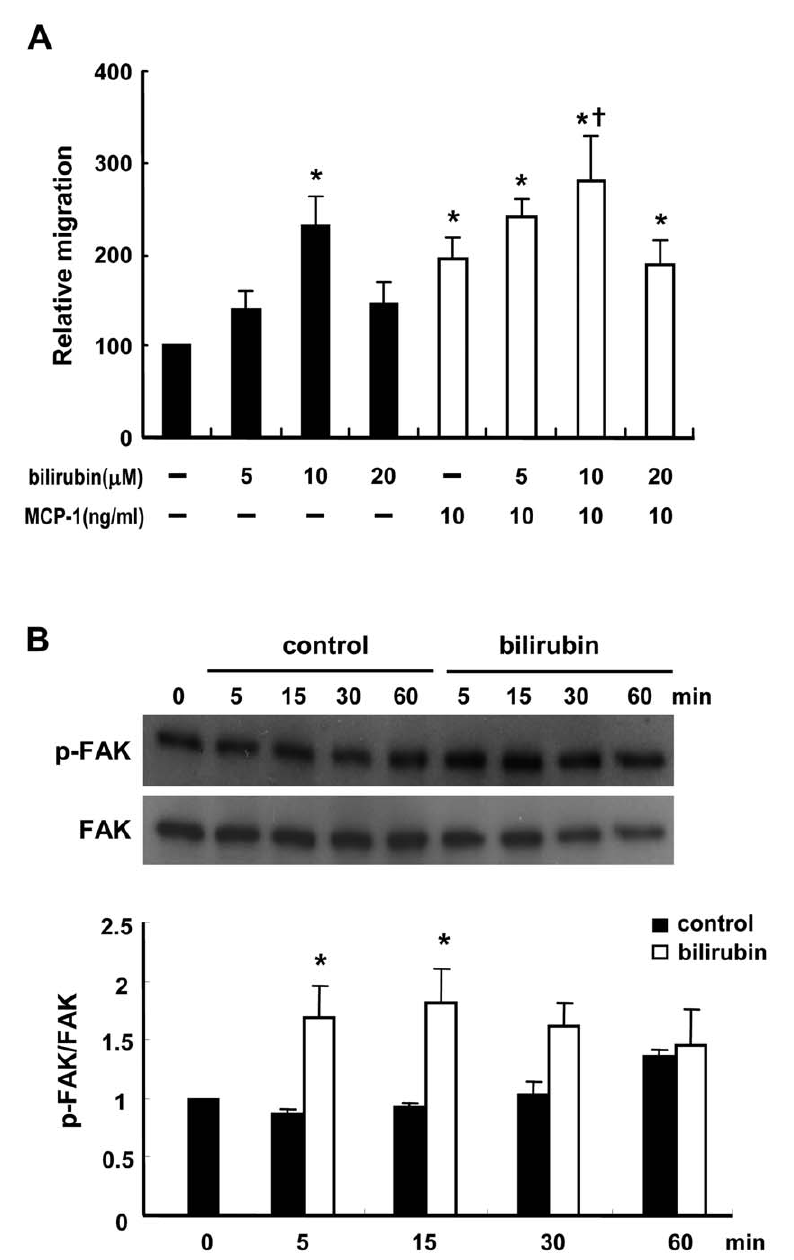
Figure 9. Bilirubin promotes macrophage migration by enhancing FAK phosphorylation. A, WT peritoneal macrophages were tested in a transwell migration assay without or with MCP-1 (10 ng/ml) and the macrophages in the upper chamber were concurrently treated without or with bilirubin at the indicated concentration. The data are the mean 6 SEM for four independent experiments. * P , 0.05 vs the untreated control. { P , 0.05 vs MCP-1 treatment. B, WT macrophages were treated without or with 10 m M bilirubin for the indicated time, then phosphorylation of FAK was examined by Western blot analysis. C, The levels of phsopho-FAK were quantified by densitometry. The data were presented as the normalized intensity relative to that of the zero-time point control group, which was set to 1. The results shown are the mean 6 SEM for three independent experiments. * P , 0.05 vs the untreated control. doi:10.1371/journal.pone.0038626.g009 levels of CD11c (M1) and mannose receptor (M2) were similar in polarization in the obese adipose tissue. Experiments were then the SVF fractions of HFD-fed WT and HO-1 + / 2 chimeras, performed to assess the inflammatory gene expression in the indicating that WT macrophages did not exhibit a preference adipocyte fractions of HFD-fed chimeras. The results showed that adipocyte TNF- a mRNA level was much higher in the WT toward M2 polarization. Although a previous study has shown that HO-1 is implicated in apoptotic cell-induced M2 macrophage chimeras than in the HO-1 + / 2 chimeras, supporting the close link polarization [28], different mechanism may underlie macrophage between increased macrophage infiltration and adipocyte inflam-